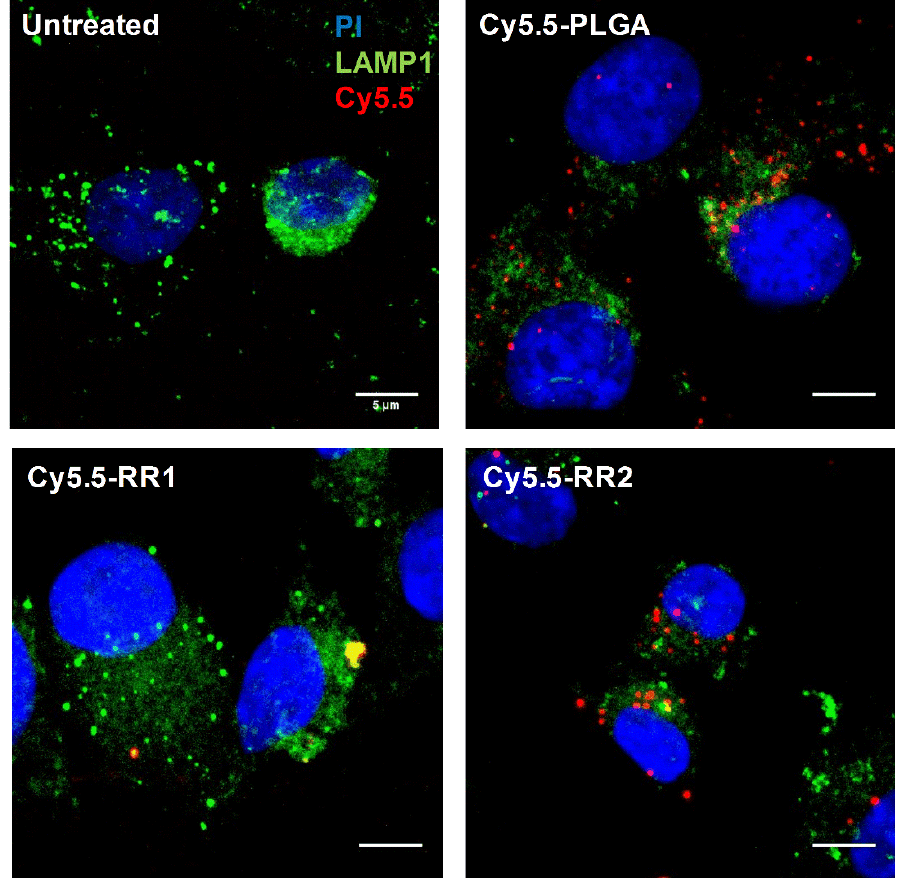
Figure 3. Nanoparticle formulations are effectively up-taken by macrophages and form punctate foci. WT BMDM were treated with 1.0 × 10 9 Cy5.5-tagged nanoparticles (red) for 1.5 h, then fixed and stained with an anti-LAMP1 antibody as a lysosomal marker (green) and propidium iodide as a DNA stain (blue). Images representative of at least 5 fields of view from n = 3. Scale bar represents 5 μm.